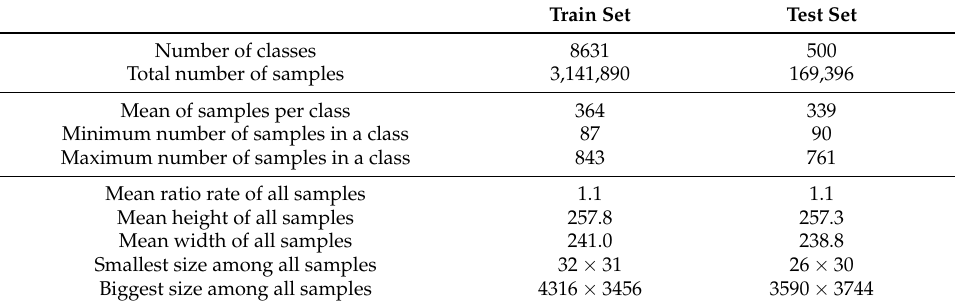
Table 3. Quantitative information about VGGFace2 train and test